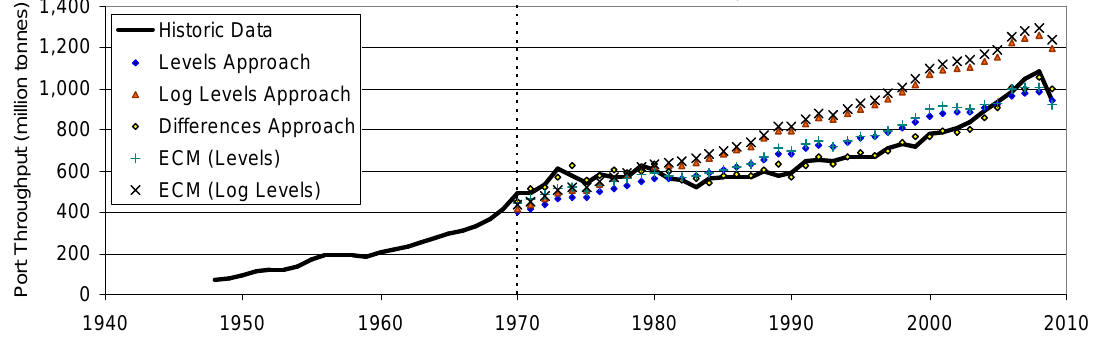
Figure 6. Ex-Post forecast from 1970 to 2009 for various forecast